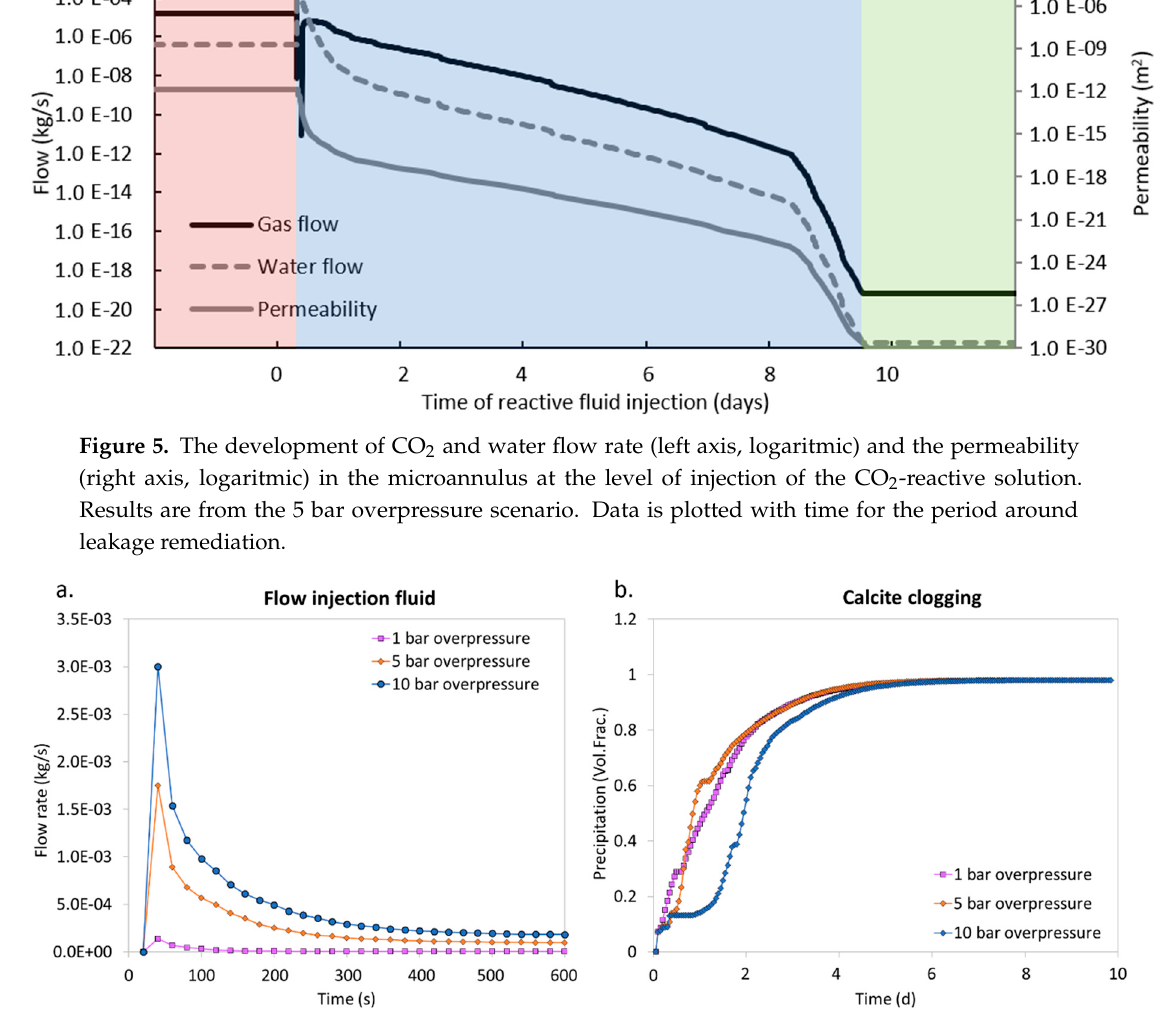
Figure 6. ( a ) The injection rate of the reactive solution for the three different injection pressures at the onset of the remediation procedure. ( b ) The evolution of calcite precipitation showing full clogging for all scenarios within the 10 days of leakage remediation.